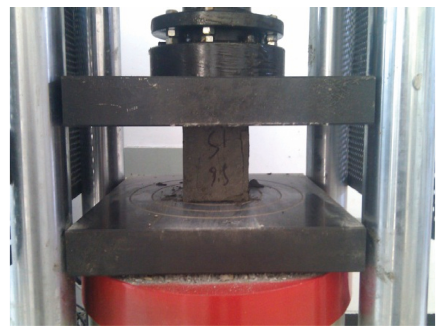
Figure 8: Test of concrete cube compressive strength.